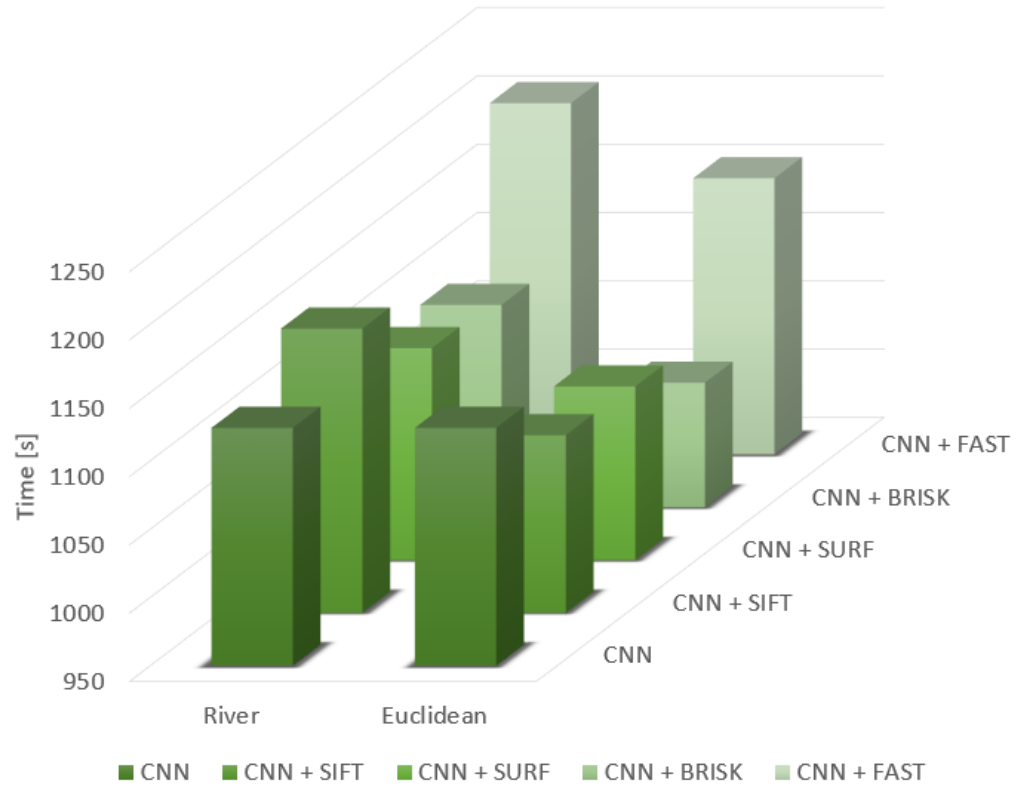
Figure 3. Average time for image processing and the training process.